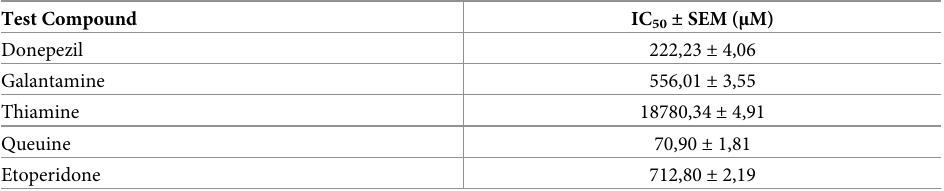
Fig 7. Percentage graph of cell viability of SH-SY5Y cells compared to the control group after exposure to different concentrations: Donepezil (A), Galantamine (B), Queuine (C), Etoperidone (D), and Thiamine (E) for 48 hours. The results represent the average ± SEM of the results from each experiment, which were repeated three times at different times with the same concentration ranges. Compared to the control, * P\0.05, ** P\0.01, *** P\0.001. https://doi.org/10.1371/journal.pone.0284994.g007 Table 5. IC 50 values for selected test compounds as AChE